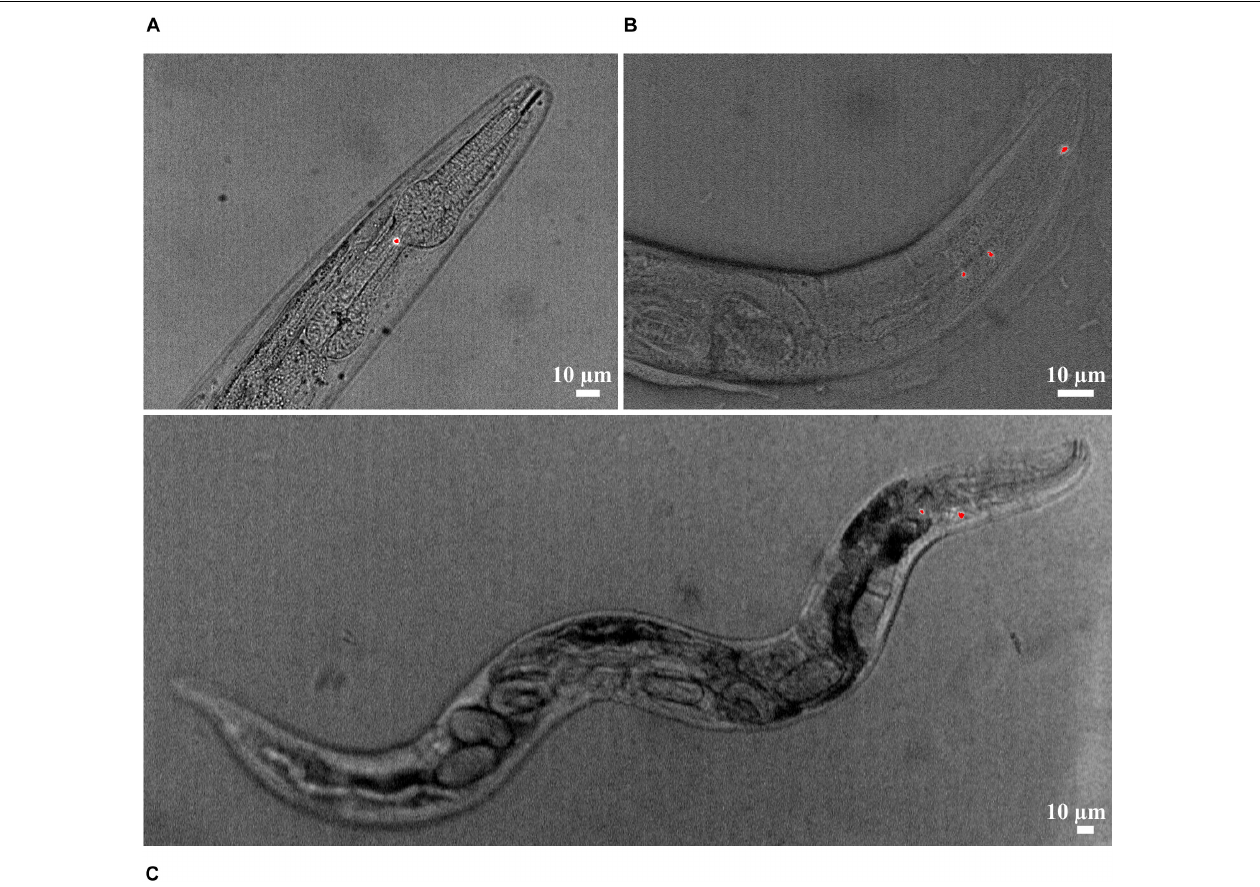
FIGURE 2 | Ingestion of NR-stained PLA/PBAT particles (red) in the (A) pharynx and (B) intestine lumen of C. elegans. (C) Nematode with NR-stained PLA/PBAT particles in the pharynx and internal hatching.